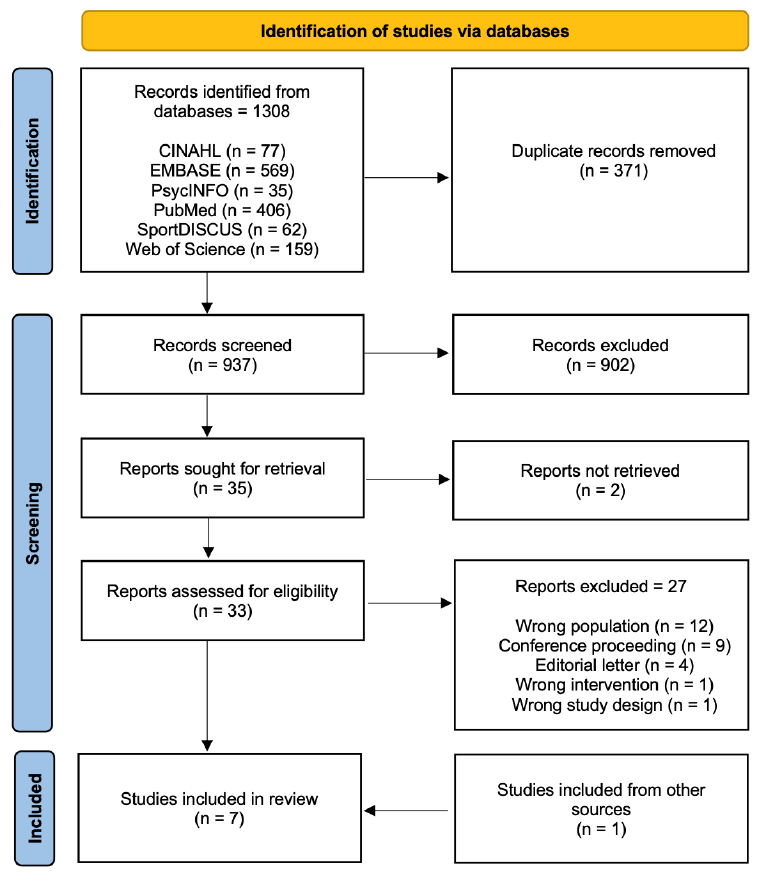
Figure 1. PRISMA